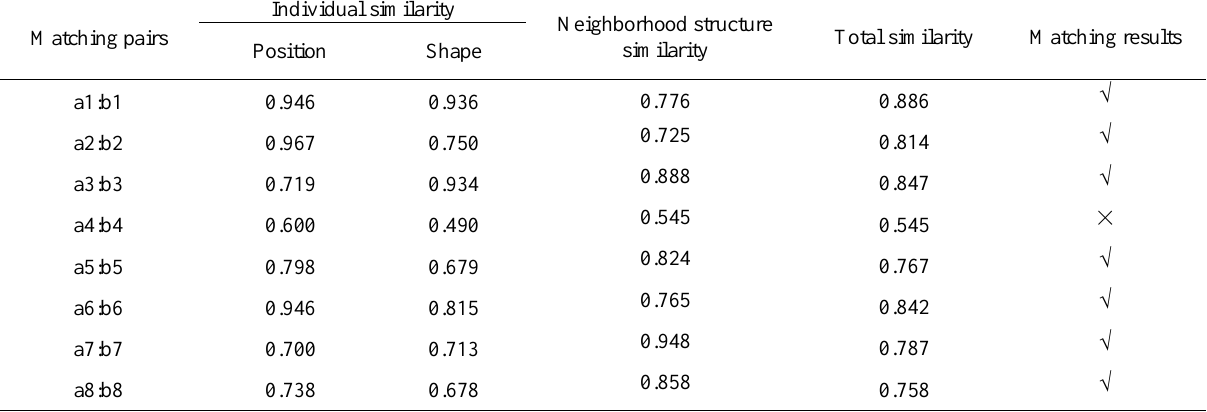
Table 1. Matching result of local shadow matching